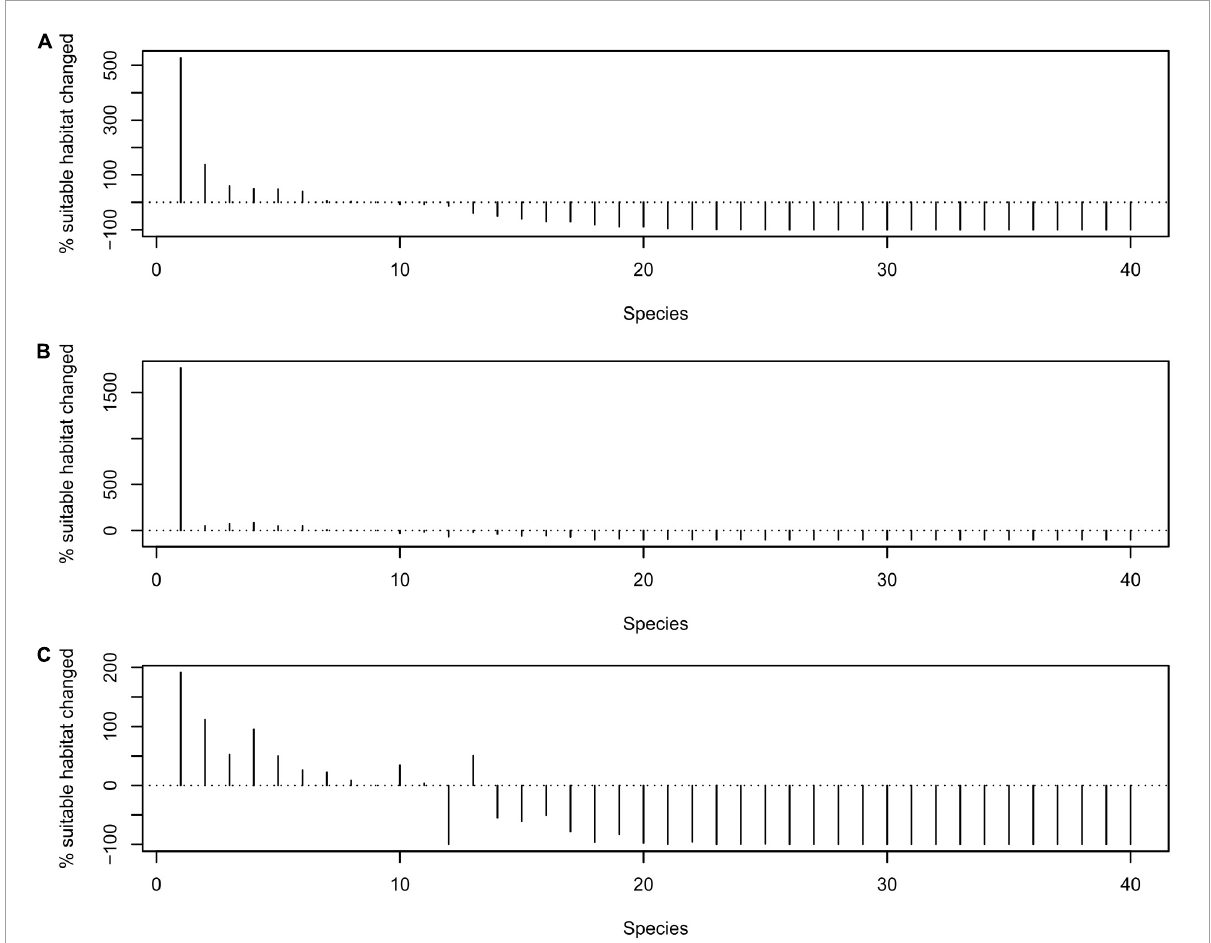
FIGURE4 Percentage change in suitable habitat size per species under (A) SSP2–4.5, (B) SSP3–7.0, and (C) SSP5–8.5. The species are 1, O. multipunctatus ; 2, S. liupanensis; 3, O. omeimontis ; 4, A. loloensis ; 5, S. wanglangensis ; 6, S. muliensis ; 7, S. chintingensis ; 8, S. tuberculatus ; 9, H. metusium ; 10, G. sukatschewi ; 11, T. wenxianensis ; 12, T. pseudoverrucosus ; 13, P. puxiongensis ; 14, P. bedfordi ; 15, L. omeiensis ; 16, T. taliangensis ; 17, R. rex ; 18, O. puxiongensis ; 19, L. boringii ; 20, S. zappeyi ; 21, O. chuanbeiensis ; 22, A. rufipectus ; 23, O. kuangwuensis ; 24, P. internigrans ; 25, B. londongensis ; 26, A. melanoleuca ; 27, B. pinchonii ; 28, B. tibetanus ; 29, E. perlacea ; 30, L. lhuysii ; 31, O. liangbeiensis ; 32, O. nanjiangensis ; 33, O. pingii ; 34, R. roxellana ; 35, S. variegaticeps ; 36, S. jiulongensis ; 37, S. pingwuensis ; 38, S. reevesii ; 39, S. przewalskii ; 40, M. nankiangensis